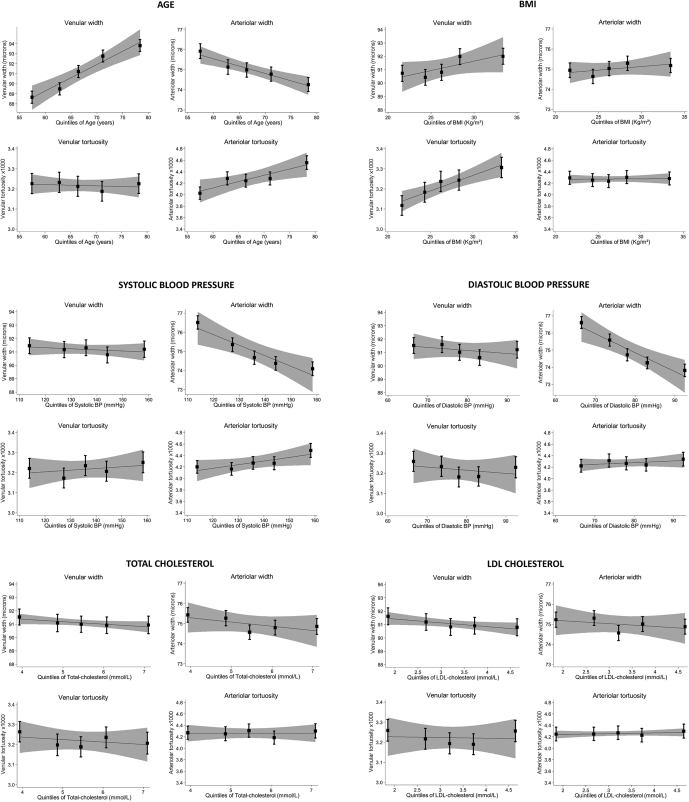
Box-and-whisker plots showing adjusted mean vessel width and tortuosity by quintiles of cardiovascular and type 2 diabetes risk factors for venues and arterioles. Adjusted means (solid square symbols), 95% confidence intervals (CIs; error bars), regression lines (solid line), and associated 95% CIs (dashed lines) are from a multilevel model allowing for age, gender, and repeated-measure of vessel indices within each person. BMI = body mass index; BP = blood pressure; HbA1c = hemoglobin A1c; HDL = high-density lipoprotein; LDL = low-density lipoprotein.